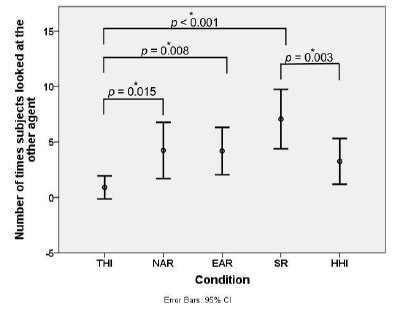
Figure 16: Graph of the Behavioral Data results related to the amount of times the adults looked at the other player among condi-